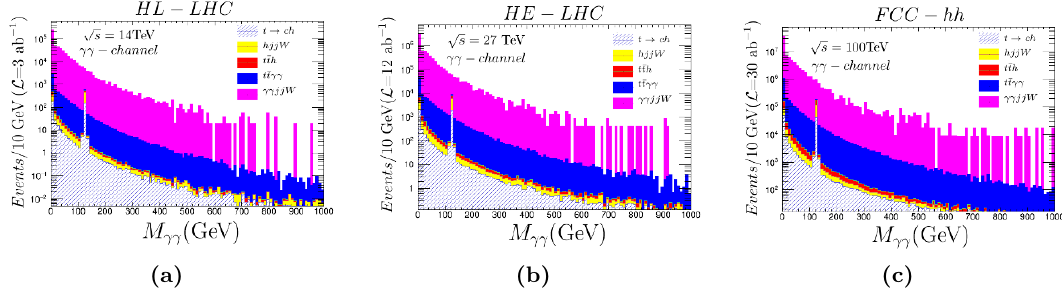
Figure 5. Invariant mass distribution of the diphoton system, M (cid:13)(cid:13) , without cuts.